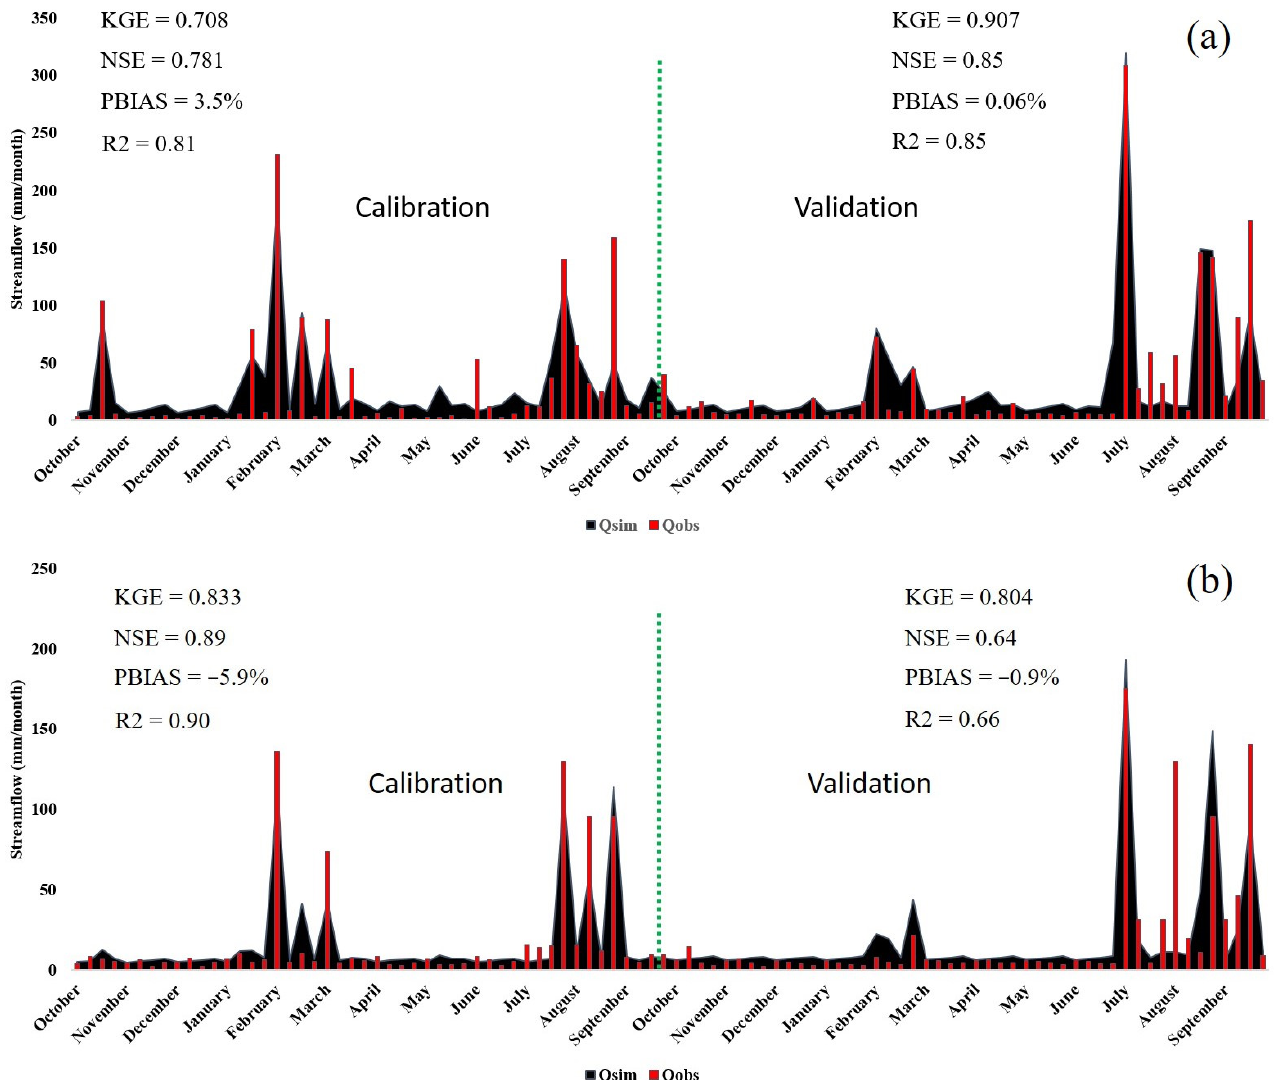
Figure 2. Monthly streamflow simulated during calibration (2002–2006) and validation (2009–2013) periods for ( a ) the Chirah sub catchment and ( b ) the Dhoke Pathan sub catchment.